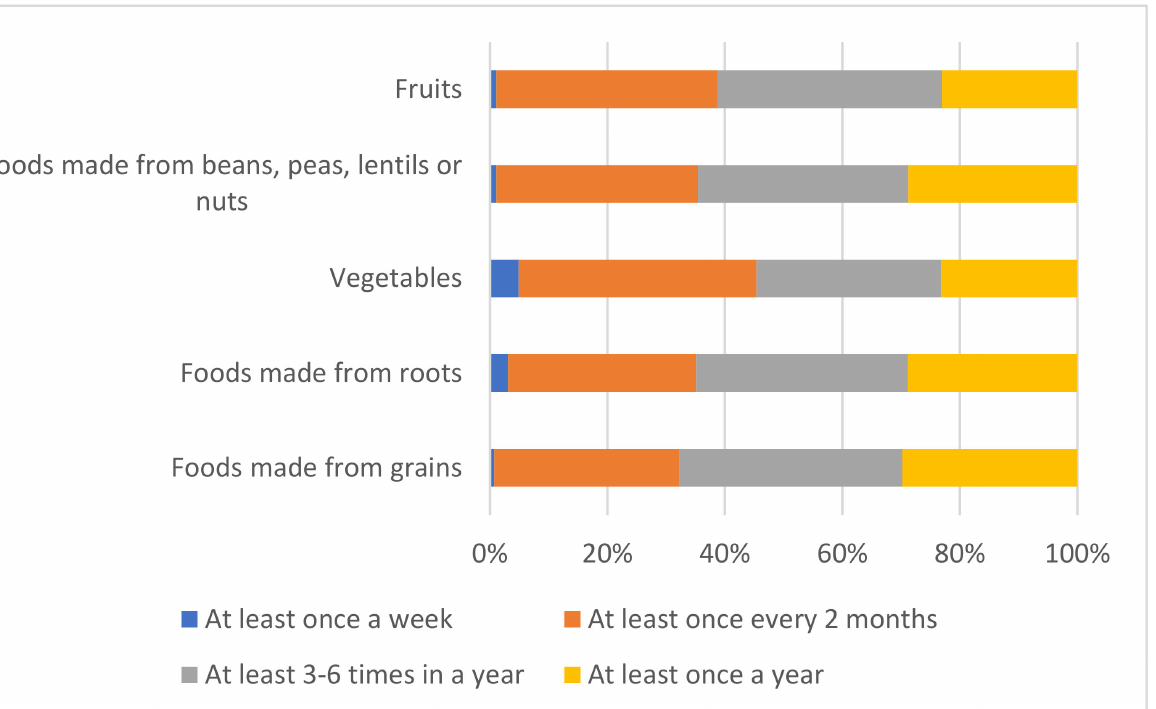
Figure 2. Frequency of Food Transfers from Rural